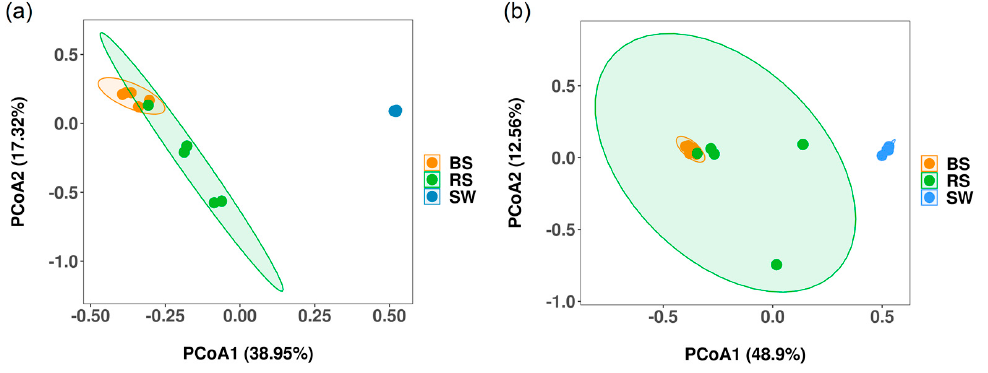
Figure 3. PCoA showing the bacterial ( a ) and fungal ( b ) community structure; RS: the seagrass rhizosphere soil samples; BS: sediment samples; SW: seawater samples. Different colored ellipsoids represent different